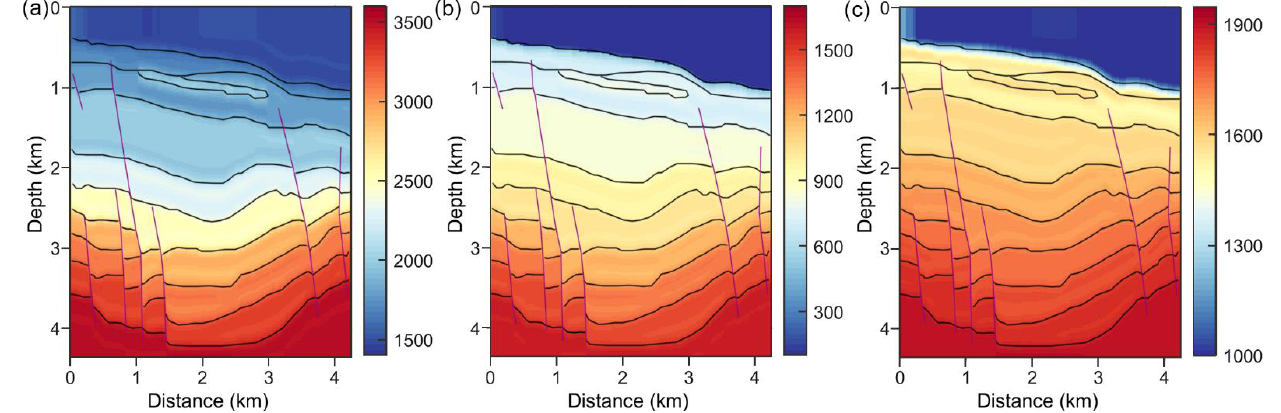
Figure 6. The background models used in the inversion method: ( a ) P-wave velocity, ( b ) S-wave velocity, and ( c ) density. The black lines indicate the stratigraphic horizons and the red lines indicate the faults.